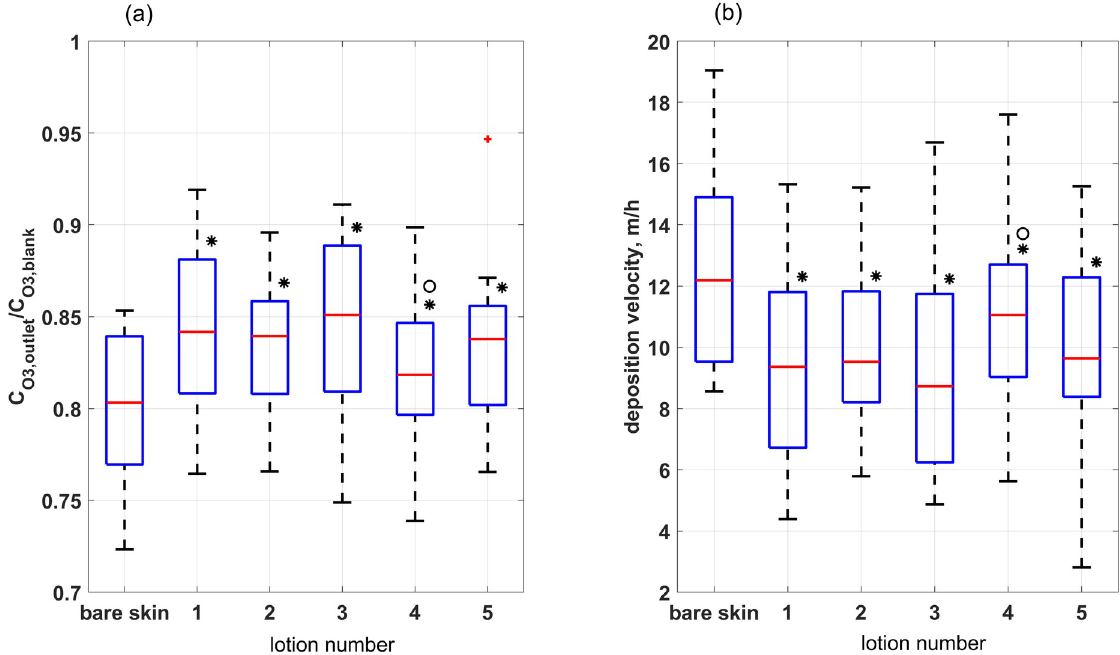
Fig 2. Ozone mixing ratios and deposition velocities. a) ratio of outlet to inlet ozone mixing ratios; b) deposition velocity. The symbol ( � ) indicate that results are significantly different from bare skin for p � 0.05. They symbol (˚) indicates that results are significantly different from lotion